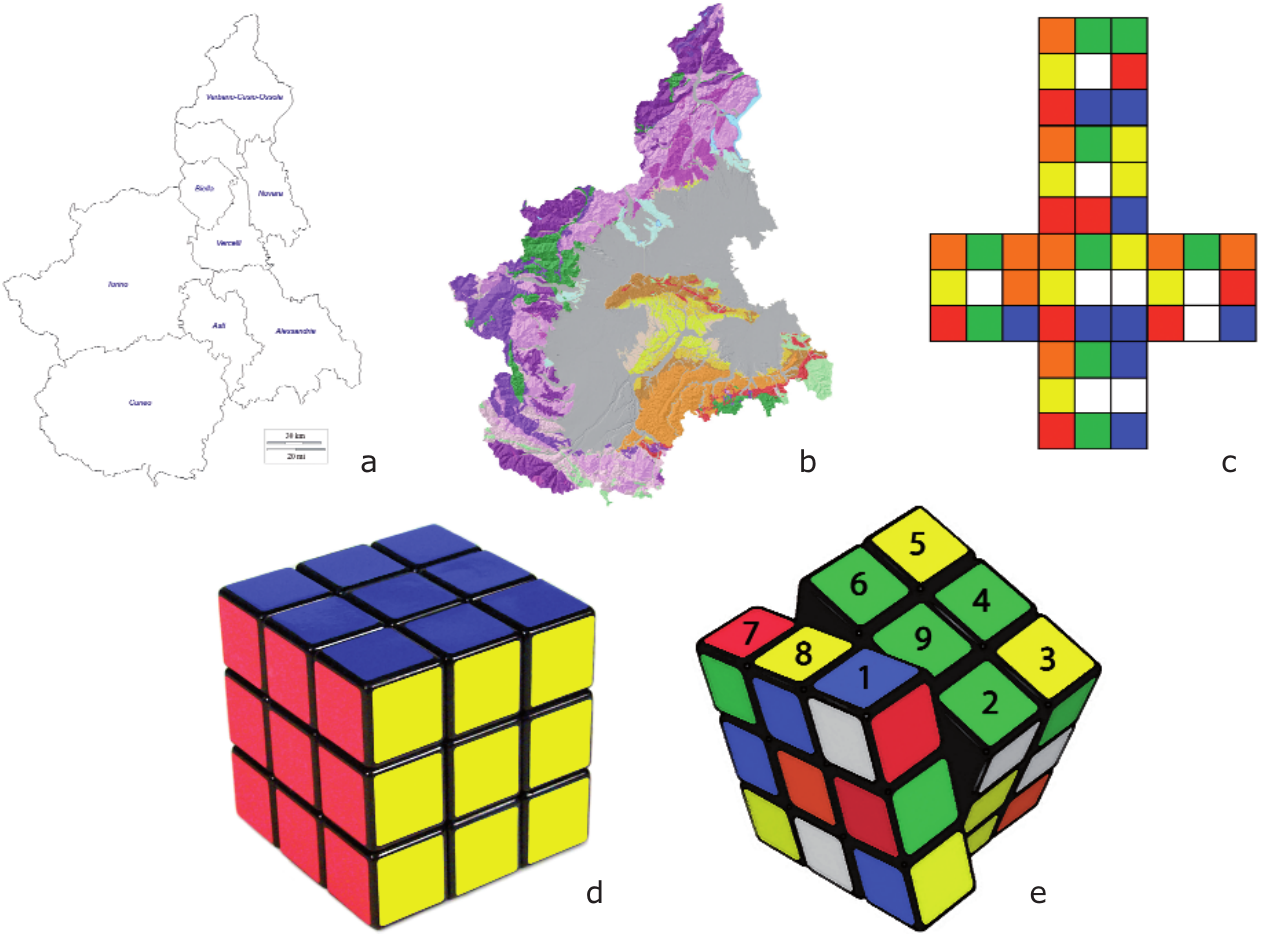
Figure 1. ‘Visual’ approach of the PROGEO-Piemonte project (see text for description). a. The Piemonte region. b. A representation of the Piemonte regional geodiversity (lithological map by Arpa-Piemonte: http://webgis.arpa.piemonte.it/geoportale/). c. The ‘disassembled Rubik cube’ analogy. d. The operating selections of the Rubik cube analogy. e. the ‘re-assembled’ Rubik cube of the geological and geographical components of the Piemonte